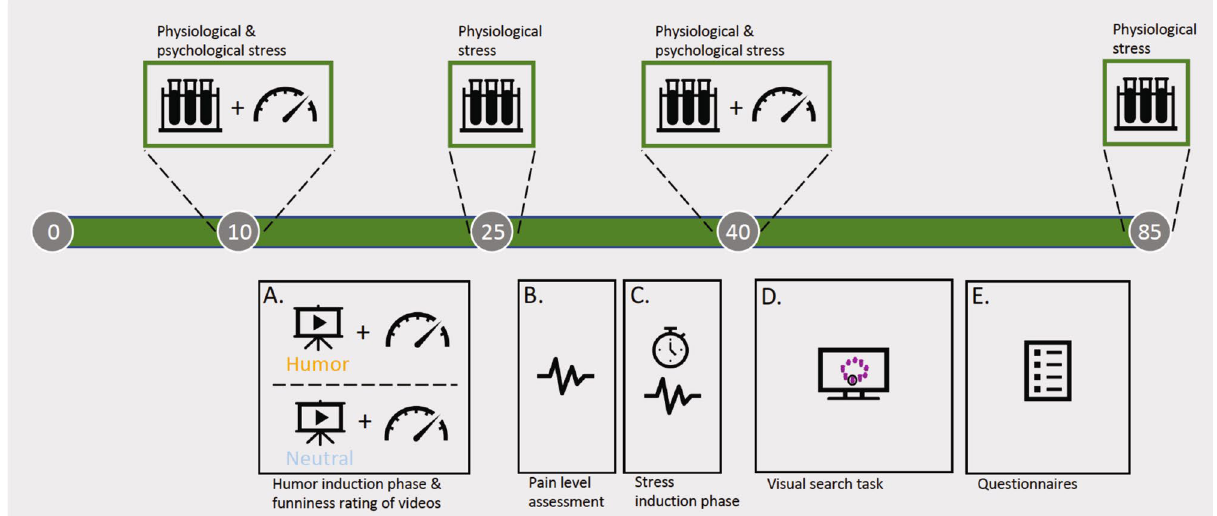
Figure 4. Study design. The upper half depicts the timepoints of salivary cortisol measurements and psychological stress ratings. The lower half shows the five phases of the experiment (A–E) . (A) Humor induction, (B) assessment of pain tolerance, (C) stress induction, (D) visual search task (cognitive performance), (E) self-assessment via questionnaires (Sense of Humor Scale and state and trait anxiety). Circled numbers denote the time in minutes from the beginning of the study. The figure was created using Microsoft PowerPoint for Mac (Version 16.43; www. micro soft.